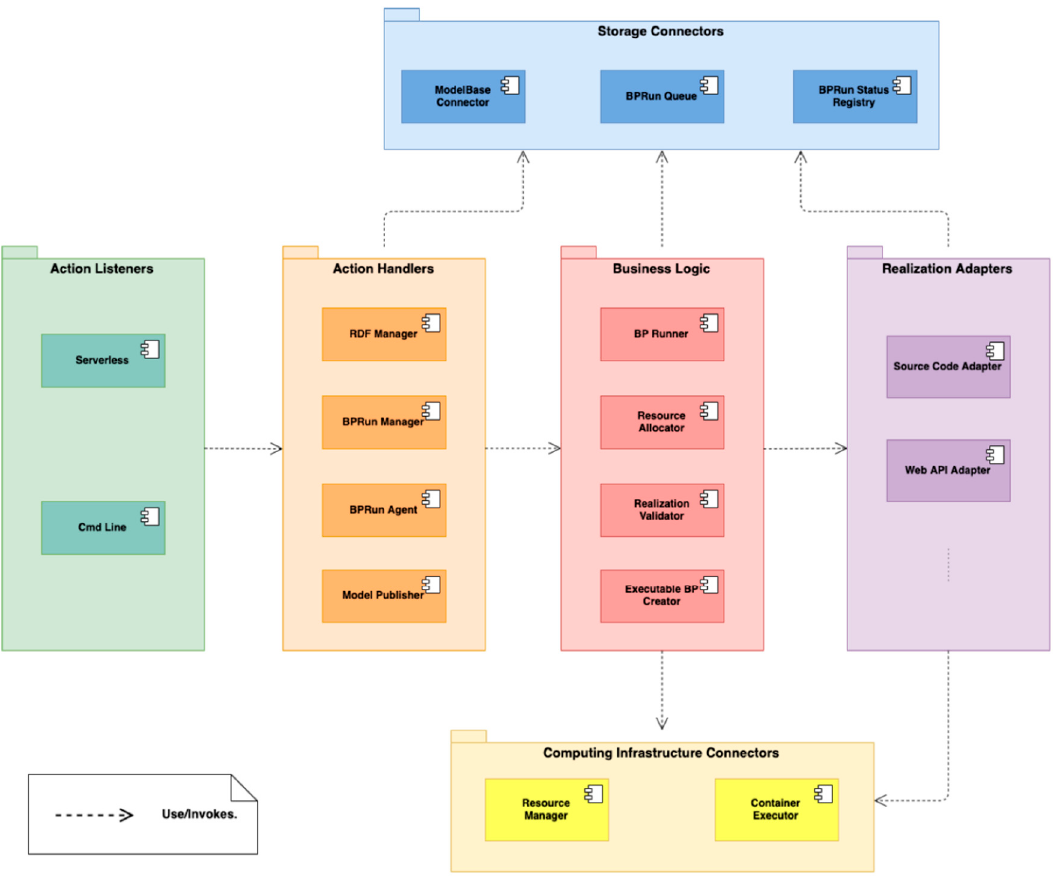
Figure 5. VLab Software Component Diagram.